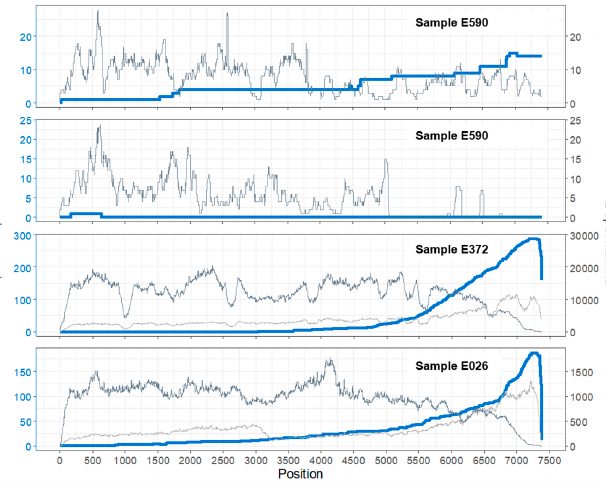
Figure 2. Coverage plots for both DRS nanopore runs (blue lines) and Illumina MiSeq (grey lines) for all three samples for each EV genotype. Shown are the depth of coverage after mapping the corresponding reads to the best reference genomes in sample E590 (top panel CA6: KJ541158.1, 2nd panel E18: HM777023.1) and E372 (MH484072.1). For E026, the coverage plot was produced by using the assembled contig sequence of the Illumina sequencing run (oligo-dT primers) as reads did not map well to any reference EV genome sequence. For samples E372 and E026, Illumina MiSeq reads based on cDNA produced with oligo-dT and random hexamers are indicated by light and dark grey lines,